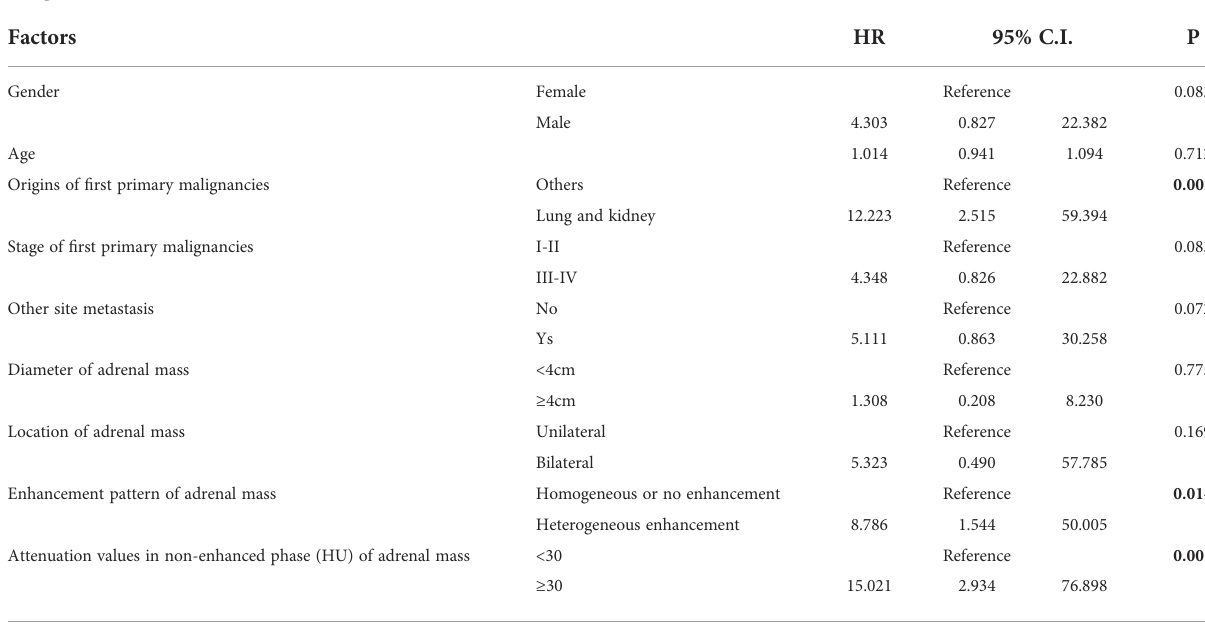
TABLE 4 Variables in the logistic regression diagnostic models to predict probability of metastasis for adrenal mass in patients with extra-adrenal malignancies. Factors